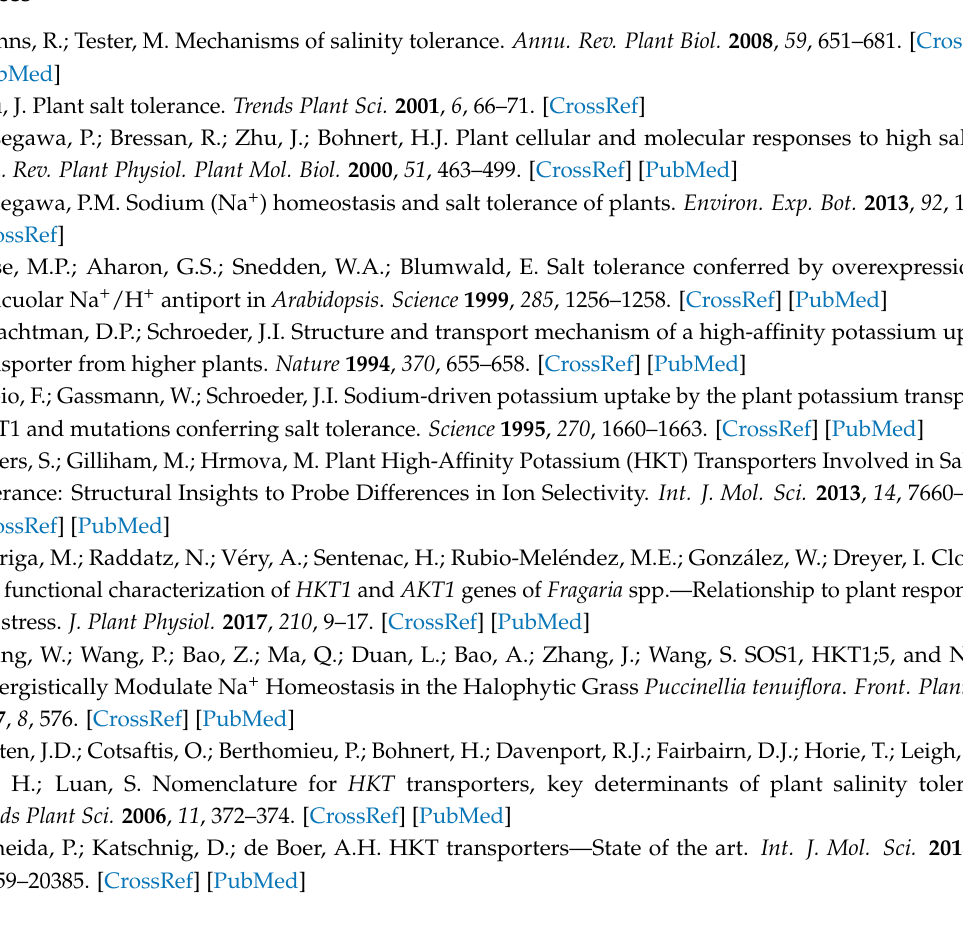
Figure S1: The pH35GS binary vector diagram, Figure S2: Multiple sequence alignment of 14 HKT proteins using ClustalX 2.1 software, Figure S3: Phenotypes of PeHKT1;1-overexpressing transgenic poplar and non-transgenic (NT) poplar under normal conditions, Figure S4: RT-PCR and qRT-PCR analyses of three-year-old transgenic poplar lines, Figure S5: Phenotypes of seven transgenic poplar lines and non-transgenic (NT) poplar transplanted into soil containing 0.2% w / v NaCl for 45 days in the greenhouse. Supplementary Data 1: The sequences of PeHKT1;1